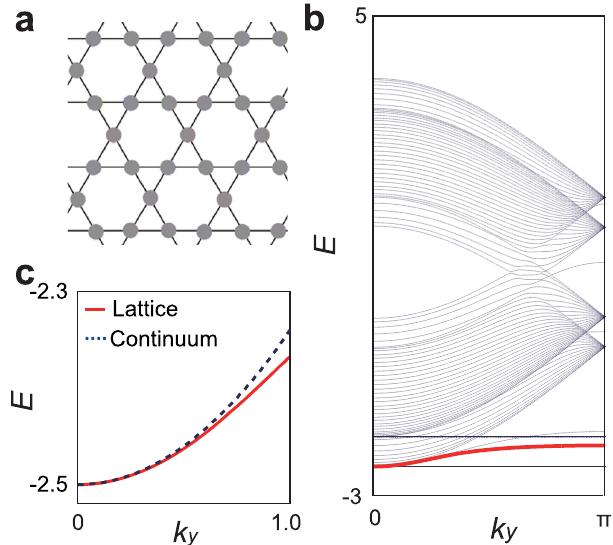
As shown in Figs. 3b and 4c, d, there are non-bulk bands between the parabolic and fl at bands. The red and green ones indicate the interface modes, while the others represent edge modes localized at the open boundaries of the systems. The models accurately near the band-crossing point. In the kagome and Lieb lattices, where d is fi xed to 1, we con fi rm that the con- max tinuum formula (5) works well as shown in the k y -dependence of the interface bands in Fig. 3c and Supplementary Fig. 1c. Note that, in the case of the kagome lattice, we apply the interface potential of the form ( U ( − ∞ ), U ( ∞ )) = ( − 2, − 2 + U 0 ) to the continuum (cid:8) Þ Hamiltonian (4) instead of U ð(cid:2)1Þ ; U ð1Þ ¼ ð 0 ; U 0 Fig. 4e, f, which shows that the wave functions becomes extended increases. as d max We examine a junction between two areas with different values ~ in the square lattice model too [see Fig. 2a]. We consider a of d max ~ ~ ð x Þ ¼ (cid:2) d step-like sign change of d such that d and max max max ~ ð x Þ ¼ d d when x < 0 and x > 0, respectively. In this system, max max